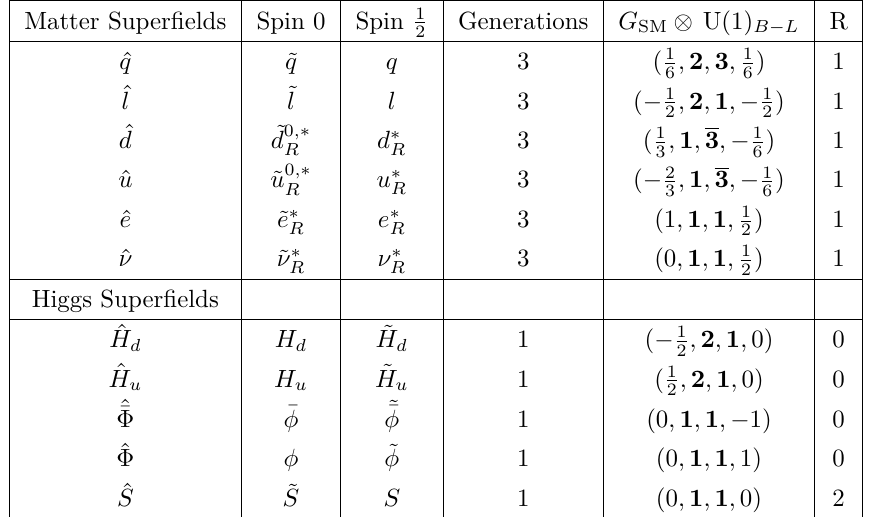
Table 1 . Chiral superfields and their charges under the local guage symmetry G SM × U(1) B − L and U(1) R